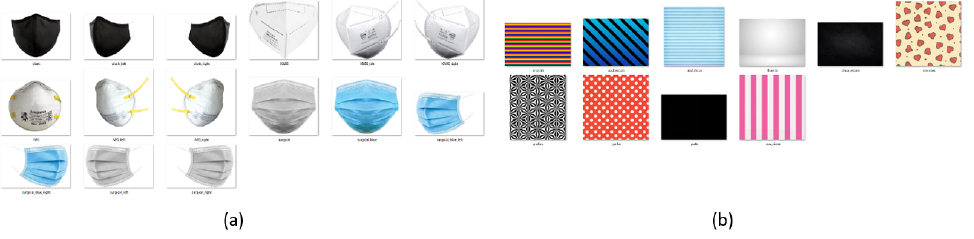
Figure 4. ( a ) Mask templates used when applying them synthetically to detected faces. ( b ) Set of examples among many mask textures applied with this tool.